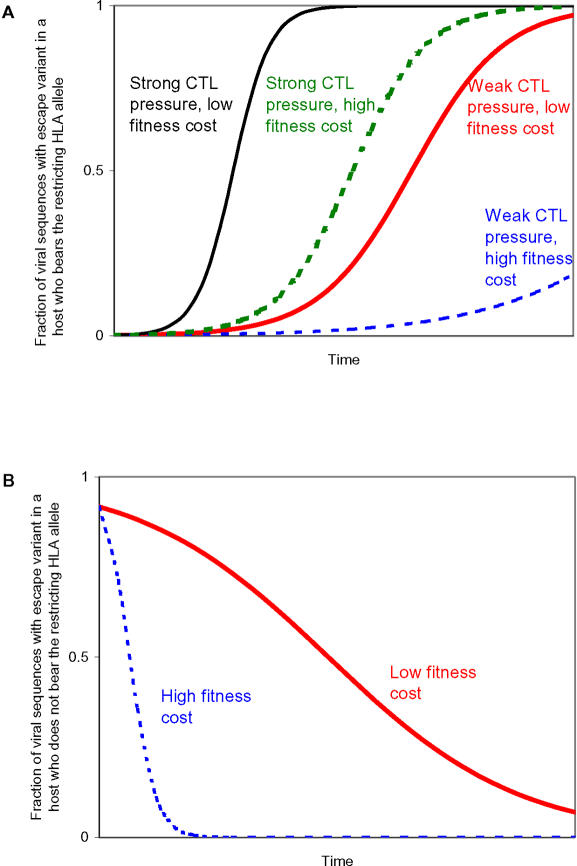
Calculating the Rate of CTL KillingWe need to know how important CTLs are in the control of HIV-1 infection, but it is not possible to measure the rate at which CTLs kill HIV-1–infected cells in vivo using conventional assays. Here we develop an alternative approach. CTL selection pressure drives viral escape, so a surrogate marker of the importance of CTLs is the rate at which CTL escape variants replace the wild-type. (A) In a host bearing the restricting HLA allele a CTL escape variant grows more rapidly than and replaces the wild-type because it is subject to a lower rate of CTL killing. The rate of replacement of the wild-type by the escape variant, “the escape rate,” is equal to the difference in growth rate of the wild-type and escape variant. If everything else were equal, the difference in growth rate would be equal to the difference in the CTL killing rate of the wild-type and the escape variant. This would mean that the CTL pressure on the specific epitope that has undergone mutation (the “escape epitope”) could be measured by the escape rate. However, everything else is not equal. Many escape variants will carry a fitness cost, which will slow the growth rate of the escape variant and thus decrease the escape rate. This fitness cost is revealed as the reversion rate when the variant is transferred to a host who does not bear the restricting HLA (B). The escape rate will therefore be equal to the rate of lysis by CTLs targeting the escape epitope minus the fitness cost. Expressed in a different way, the rate of lysis of HIV-1–infected cells by CTLs targeting the escape epitope is equal to the escape rate plus the reversion rate. In (A) the relative position of the two lines “strong CTL pressure, high fitness cost” and “weak CTL pressure, low fitness cost” could be interchanged depending on the magnitude of the differences in CTL strength and variant fitness.